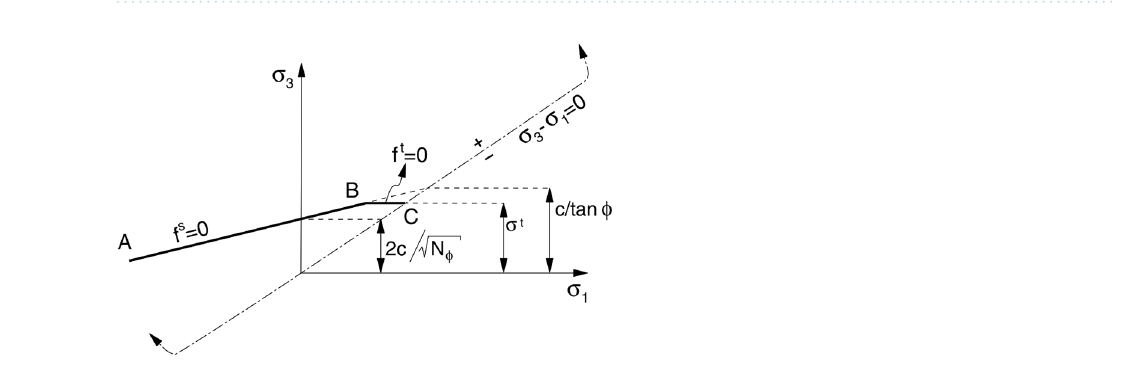
Figure 7. Constitutive model for the block